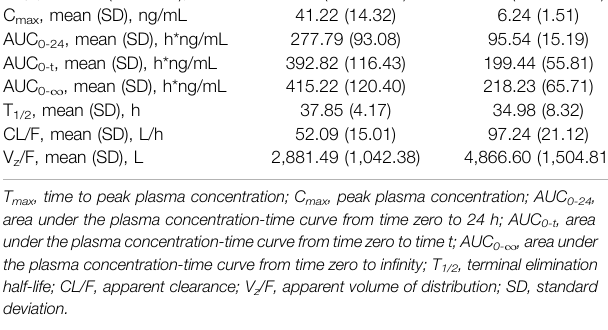
TABLE 6 | Geometric mean ratios of pharmacokinetic (PK) parameters in the fasted and fed states. PK parameter